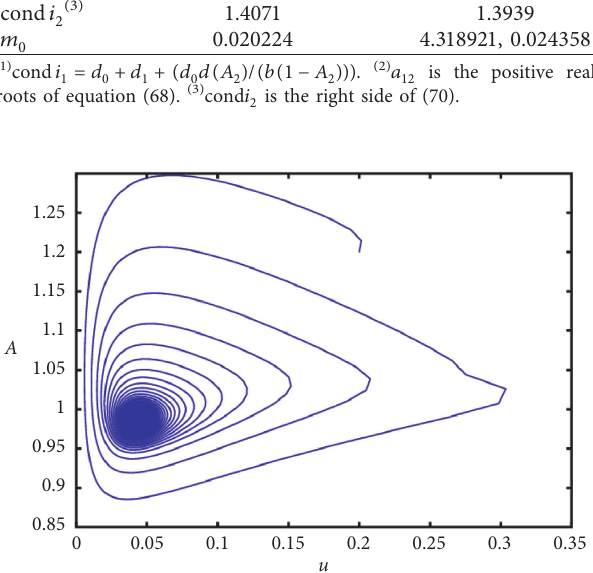
� 0 . 3, d � 0 . 2, d � 0 . 7, and 0 1 2